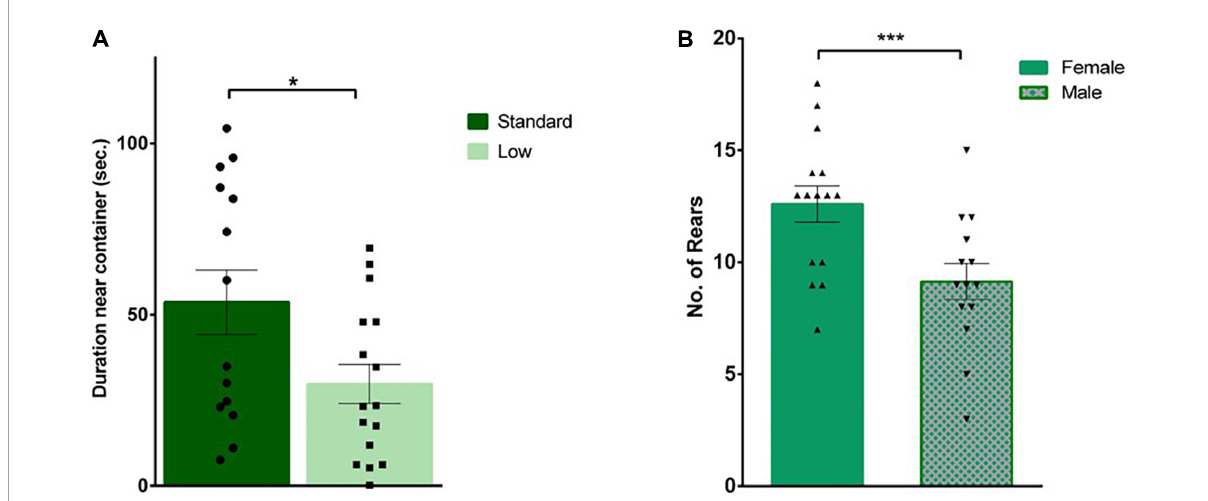
FIGURE5 Social interaction task. During habituation, an empty plastic container was placed in the arena for rats to explore prior to the social test. (A) Standard-reared rats ( • ) were found to spend a significantly greater amount of time near the empty container compared to rats raised in a low resource setting ( (cid:4) ), (* p = 0.026; n = 16 for SR group, n = 14 for LR groups). (B) During the social interaction trial, when an unfamiliar rat was placed in that plastic container, a significant sex effect was observed where females ( (cid:78) ) exhibited a greater number of external rears compared to male rats ( (cid:72) ) (*** p = 0.004). Data represent individual animals over bars showing means ± SEM ( n = 16 for females, n = 14 for males).